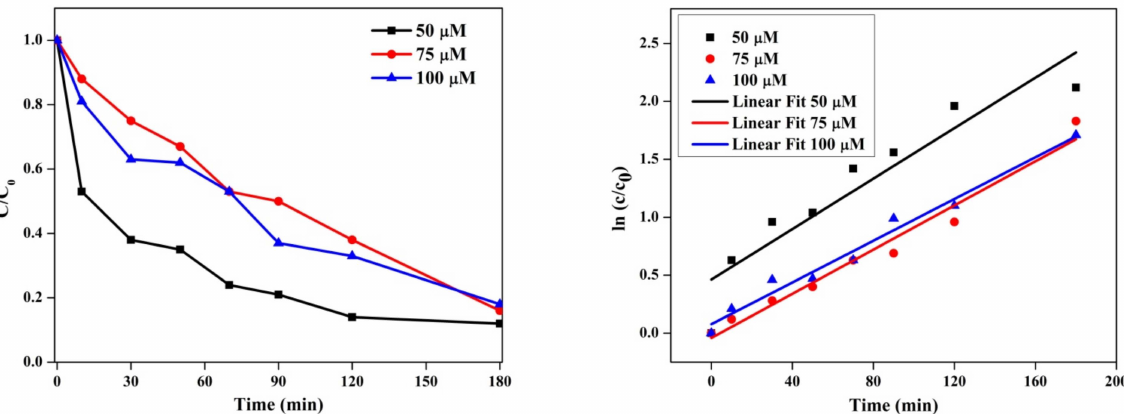
Figure 13. Plot of time vs. c/c 0 and time vs. ln c/c 0 for photocatalytic degradation of methylene blue dye.